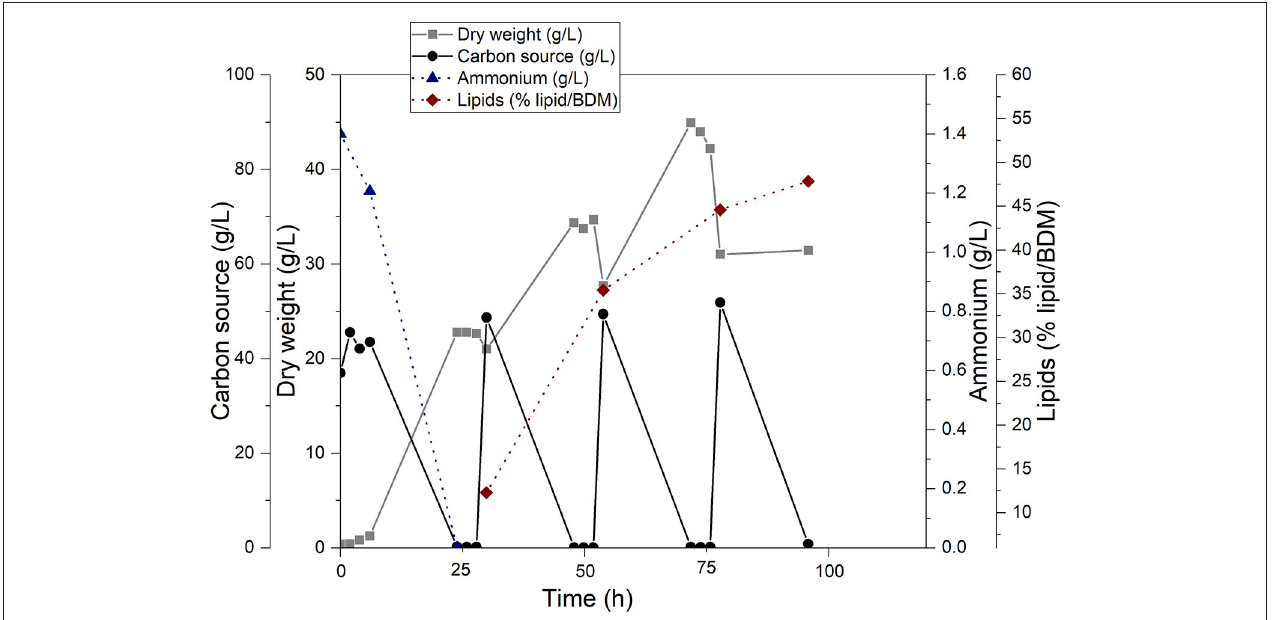
FIGURE 2 | Production of single cell oil with the oleaginous yeast Cryptococcus curvatus ATCC 20509 in a 2.5L bioreactor using cellulose fiber hydrolysate from beech wood. All concentrations are given as averages of two independent bioreactor cultivations. The individual values can be found in Supplement 1